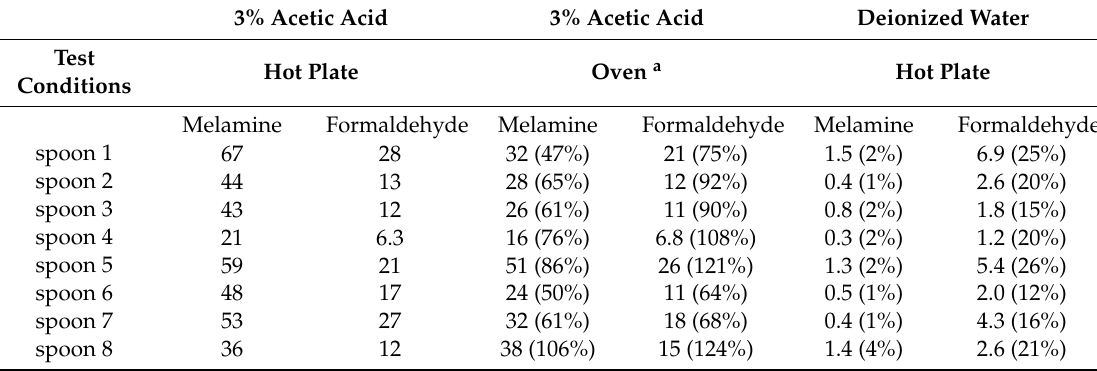
Table 3. Results of the third release of melamine and formaldehyde (mg/dm 2 ) into food simulants under different migration conditions and the ratio (%) of that migration compared to 3% acetic acid on a hot plate (spoons 1–3 are of the same type as in the first experiments).